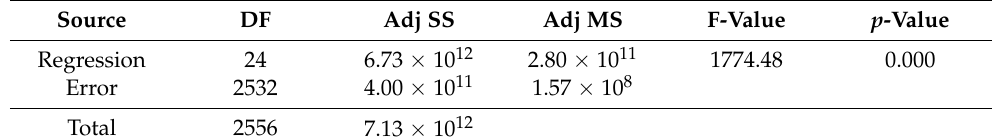
Table 1. Analysis of variance of